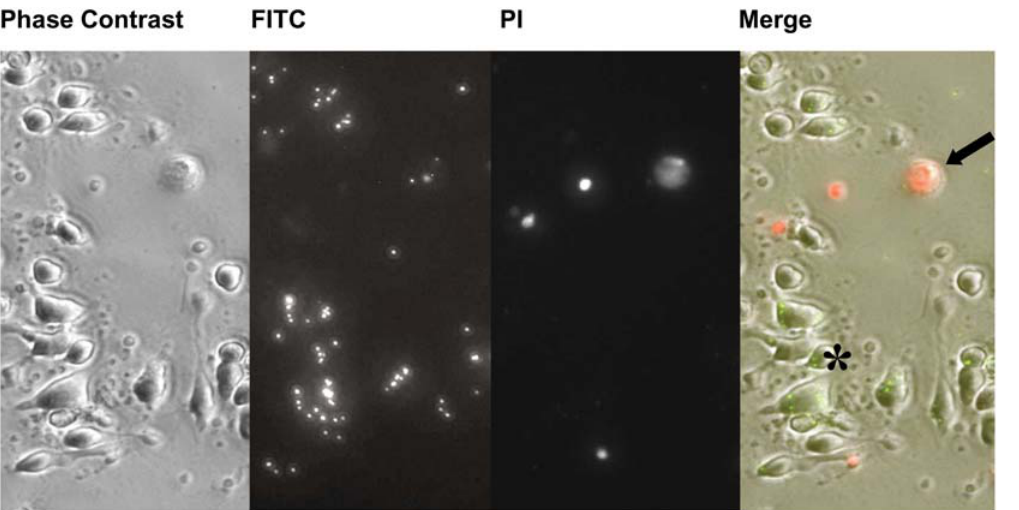
Figure 3. The intracellular presence of S.aureus protects macrophages (RAW 264.7) from STS-induced cell death. Macrophages were allowed to phagocytose FITC-labeled S. aureus at a ratio of 5 bacteria per macrophage (MOI=1:5) for 2 h. Extracellular bacteria were removed and cells were cultured in media with antibiotic for an additional 24 h, before being treated with STS (1 m M) in fresh culture medium for 3 h. Subsequently, cell viability (PI staining), as well as the presence of intracellular bacteria, were analyzed using a fluorescence microscope. (The figure presents transmission and fluorescent light micrographs of macrophage cultures infected with FITC-labeled S. aureus and treated with STS. The merged panel represents PI stained dead uninfected cells (arrows); and viable macrophages with intracellular S. aureus which maintained their cell membrane integrity (asterisks). The figure shows representative results of three independent experiments.